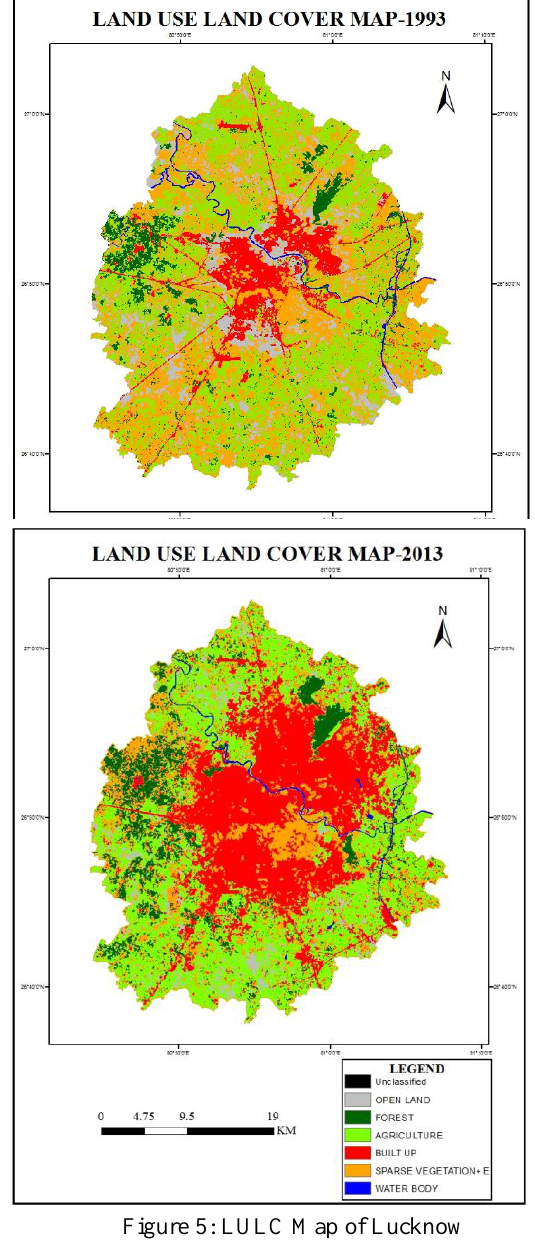
Figure 5: LULC Map of